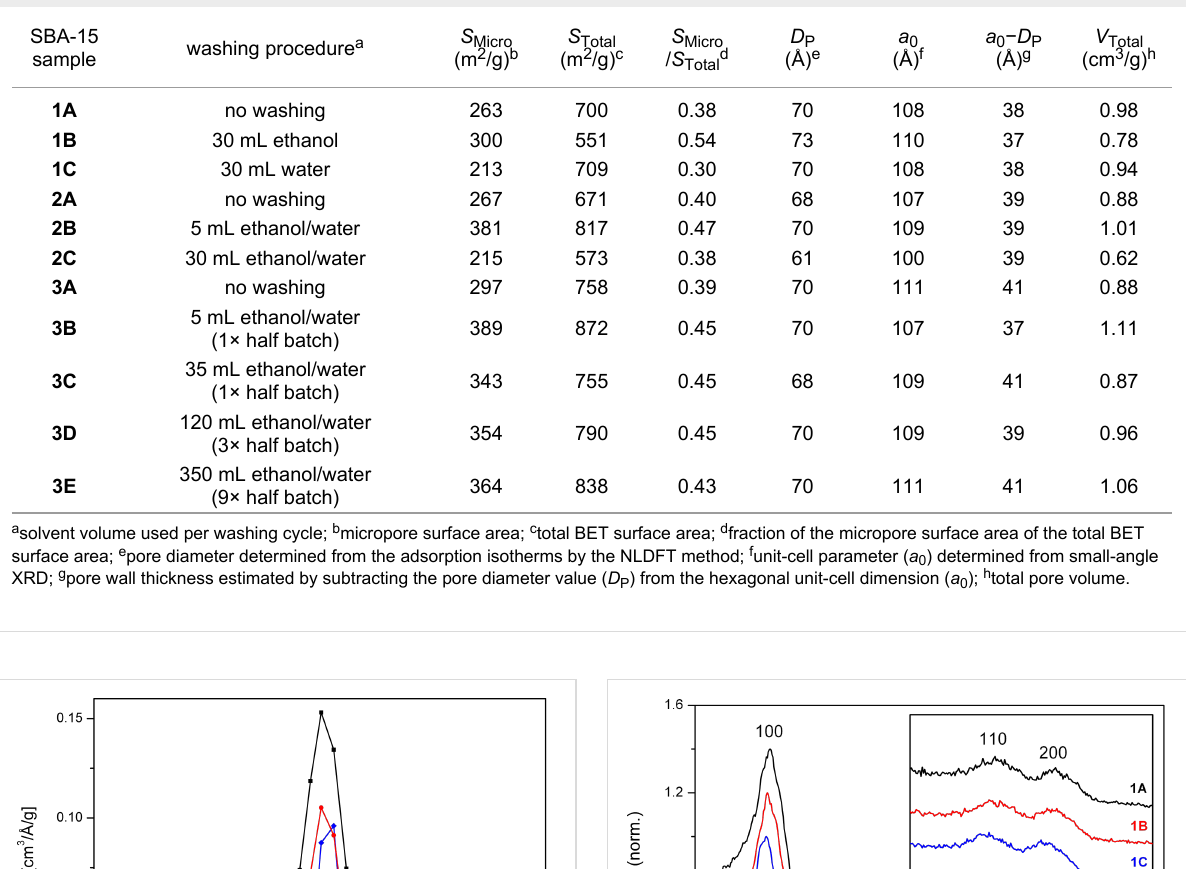
structure of the SBA-15. Therefore, according to their recom- mendation (viii) the TEOS/surfactant ratio was fixed to 58:1 for all samples to exclude it as source for the observed